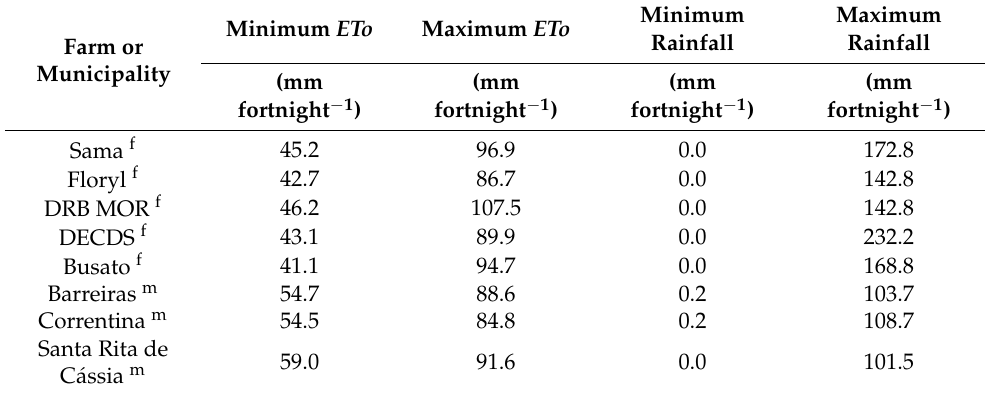
Table 2. Minimum and maximum rainfall values observed for each farm or